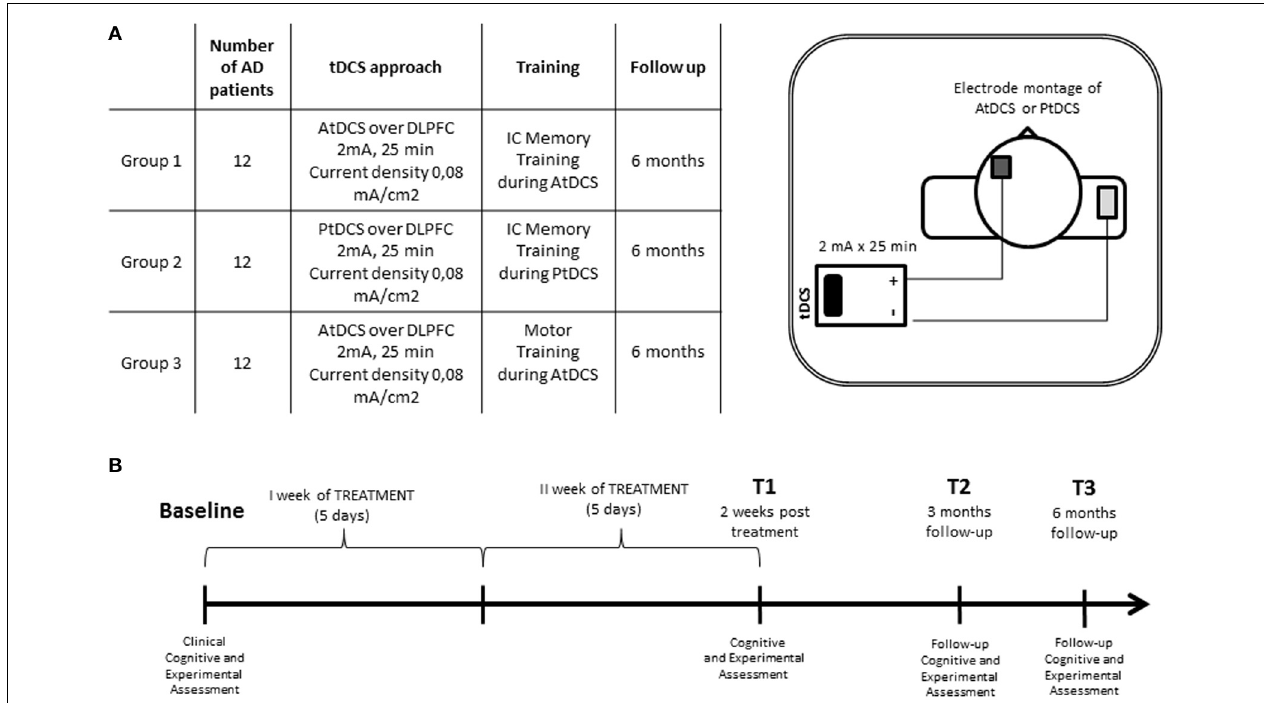
FIGURE 2 | (A) Experimental conditions and electrode montage of AtDCS and PtDCS. (B) Experimental protocol of transcranial direct current stimulation combined with individualized computerized memory